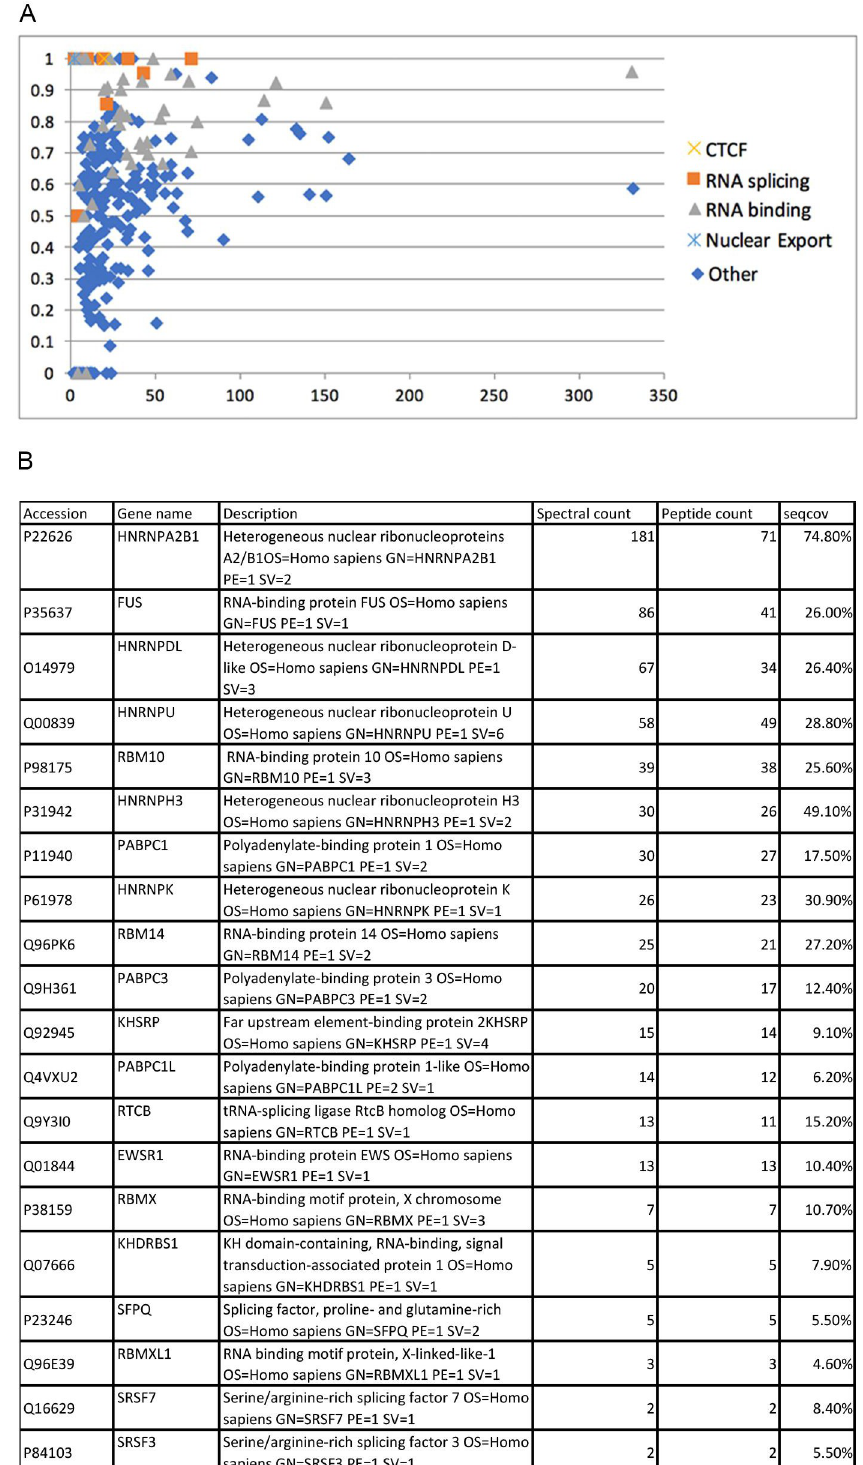
Fig 3. Analysis of functional annotation clustering for CTCF mass spectrometry hits. (A) DAVID Bioinformatics Resources 6.7 was used to analyze functional annotation clustering results from the mass spectrometry hits for CTCF cellular interaction partners, highlighting enrichment of RNA splicing and RNA binding proteins. (B) Table of top- scoring relevant CTCF mass spectrometry hits.